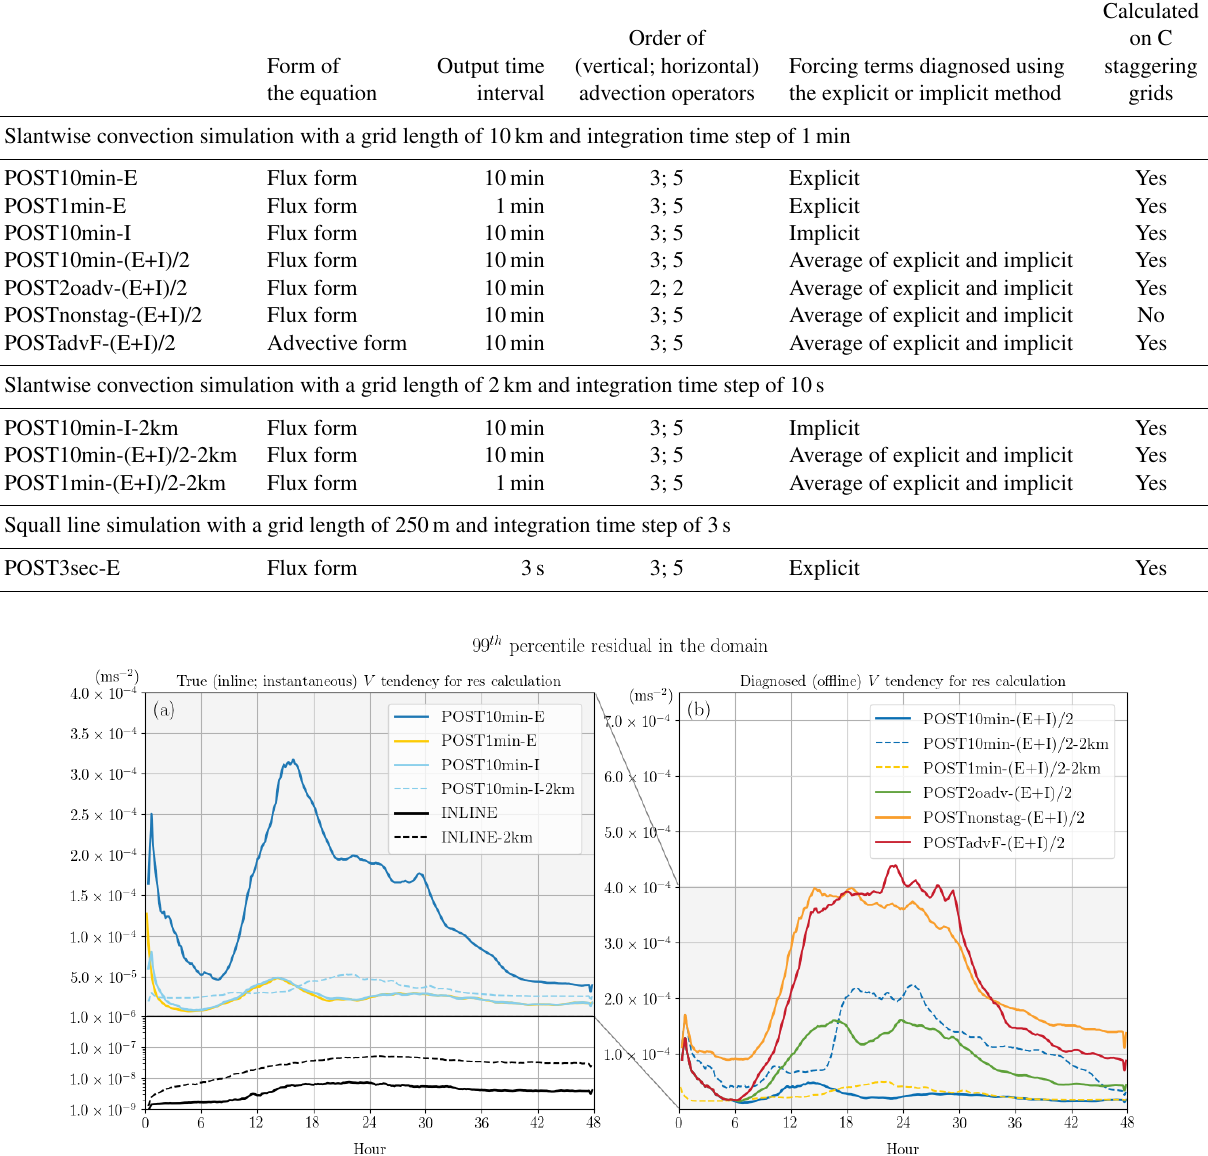
Figure 5. Evolution of the 99th percentile of the residual magnitude (meters per second squared) of the horizontal momentum V budget analysis. For the residual calculation, (a) uses the true V tendency (derived during the integration of the model) and (b) uses the post- diagnosed V tendency (Eq. 8) as the lhs term. Different colors indicate different post-processed methods for estimating the rhs forcing terms. The residuals obtained from the inline budget retrieval are in black. Solid and dashed lines are for the 10km run and 2km run, respectively.